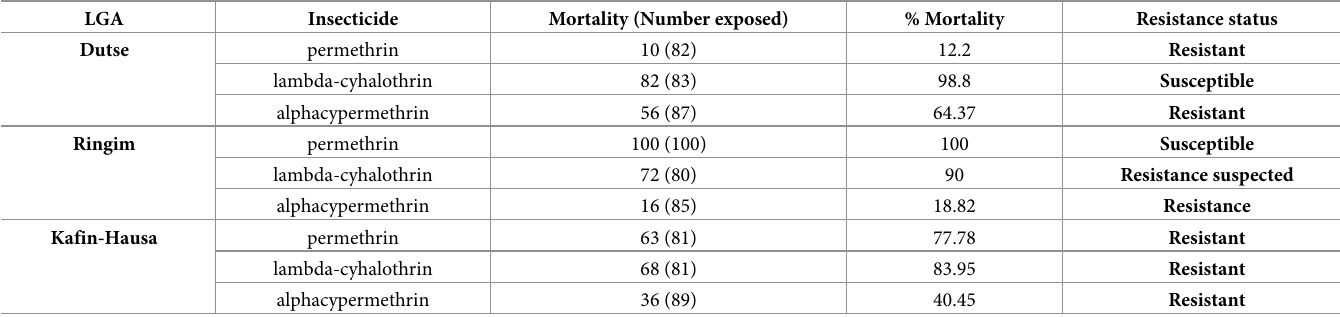
Population was considered susceptible when mortality � 98%; Population was suspected to be resistant when mortality is � 90% but < 98%; Population was considered resistant when mortality is <